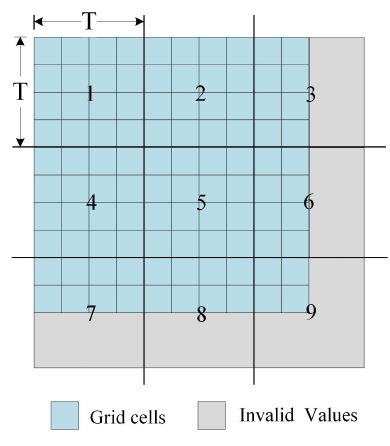
Figure 5. The tile partitioning